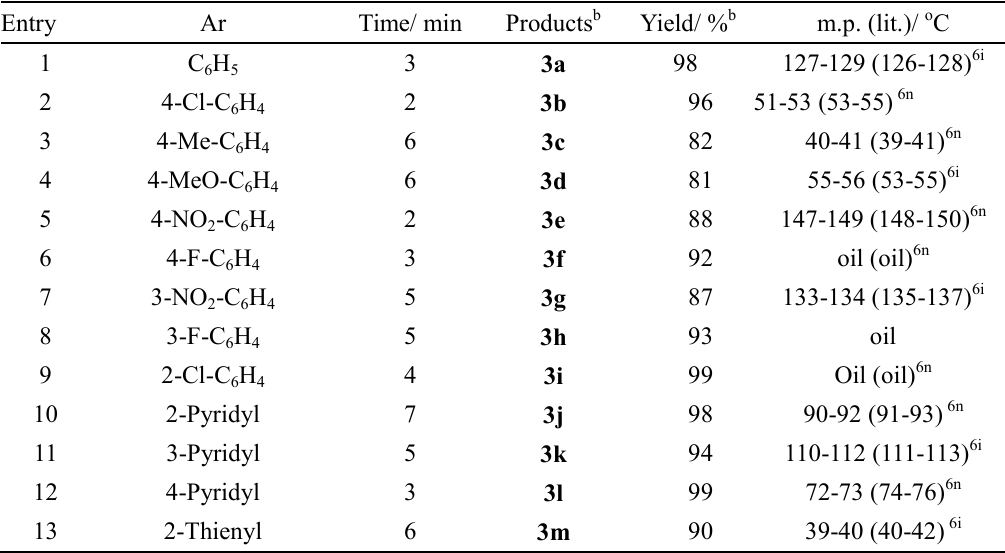
Table 3. Preparation of 2-arylthiazolines a